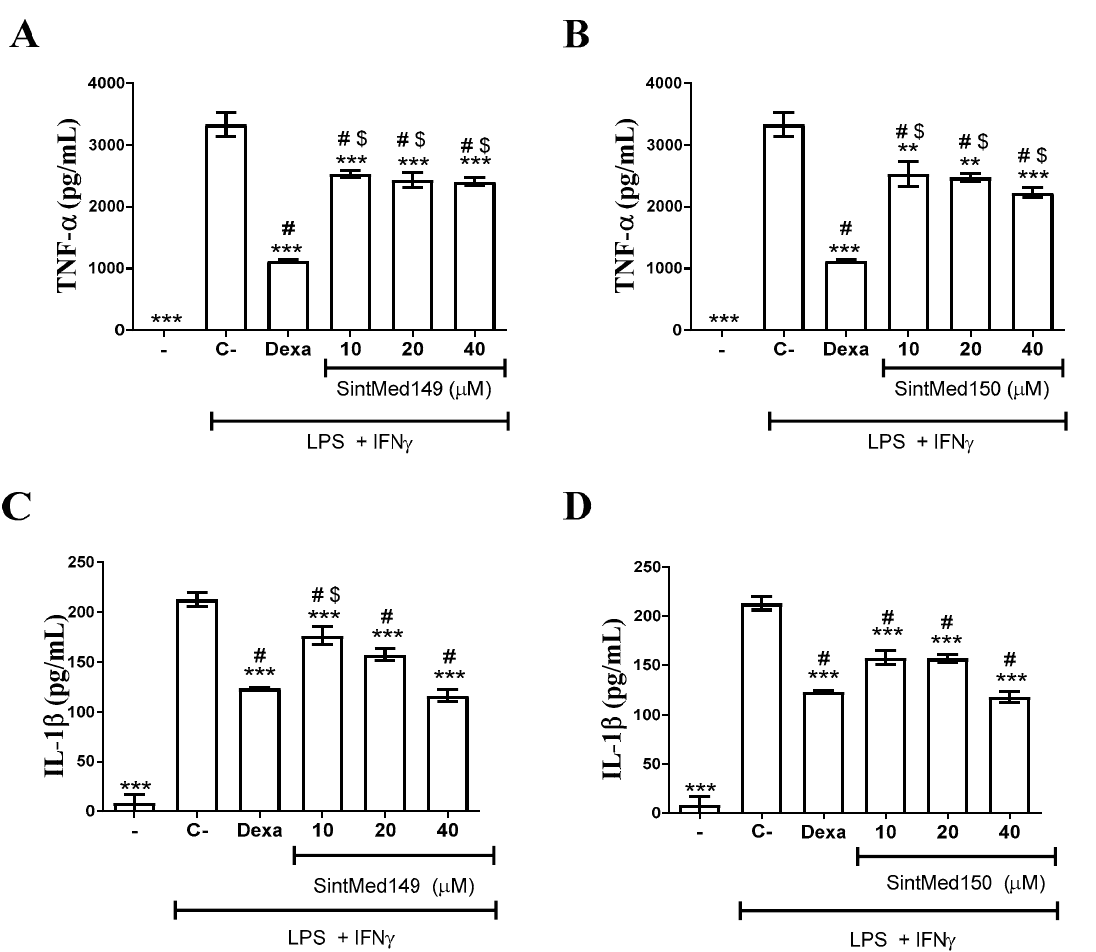
Figure 5. Assessment of cytokine production by peritoneal macrophages treated with SintMed149 or SintMed150 . Mouse peritoneal exudate macrophages stimulated or not with LPS + IFN- γ were cultured in the absence or presence of SintMed149 ( A , C ) or SintMed150 ( B , D ) (10, 20, and 40 µ M) or dexamethasone (Dexa; 10 µ M). Cell-free supernatants were collected after 4 h for TNF α quantification (A and B) or 24 h for IL-6 quantification (C and D). “-” refers to the group of untreated and unstimu- lated cells. C- refers to the group of untreated cells stimulated with LPS + IFN γ . Values represent the mean ( ± standard deviation) of four determinations obtained in one of three experiments performed. *** p < 0.001 compared to stimulated and untreated cells; ** p < 0.01 compared to stimulated and untreated cells; # p < 0.05 compared to unstimulated and untreated cells; $ p < 0.05 compared to dexamethasone-treated